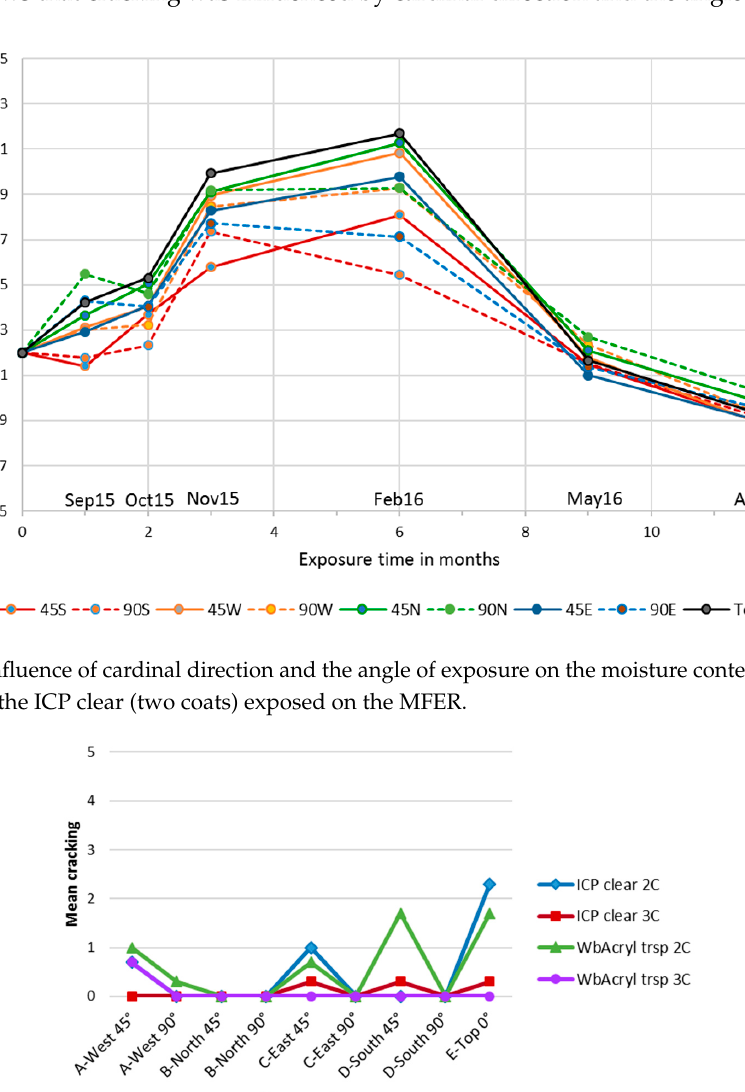
Figure 14. Influence of cardinal direction and the angle of exposure on coating cracking after 12 months of exposure using the MFER.